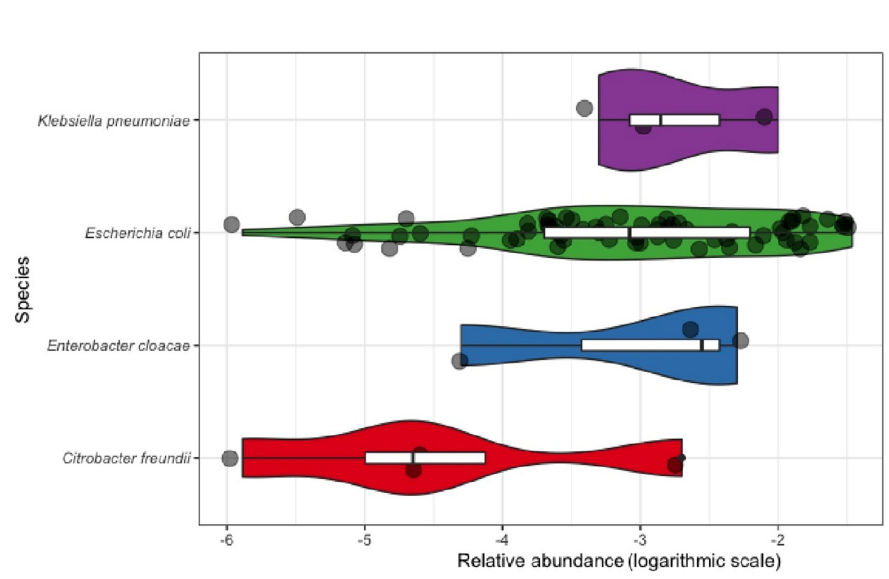
Fig 12. CRE relative abundance of the different species of Enterobacterales